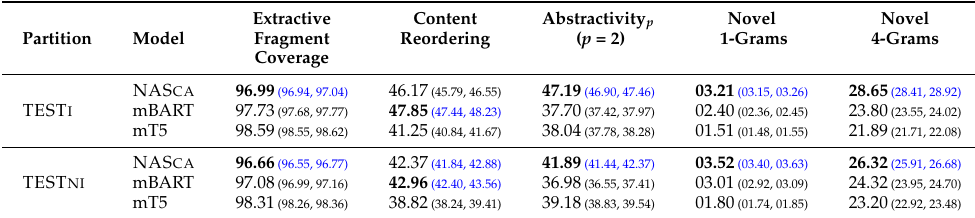
Table 6. Abstractivity indicators and confidence intervals for Catalan. Values are shown as percentages. Extractive Content Abstractivity p Novel Novel